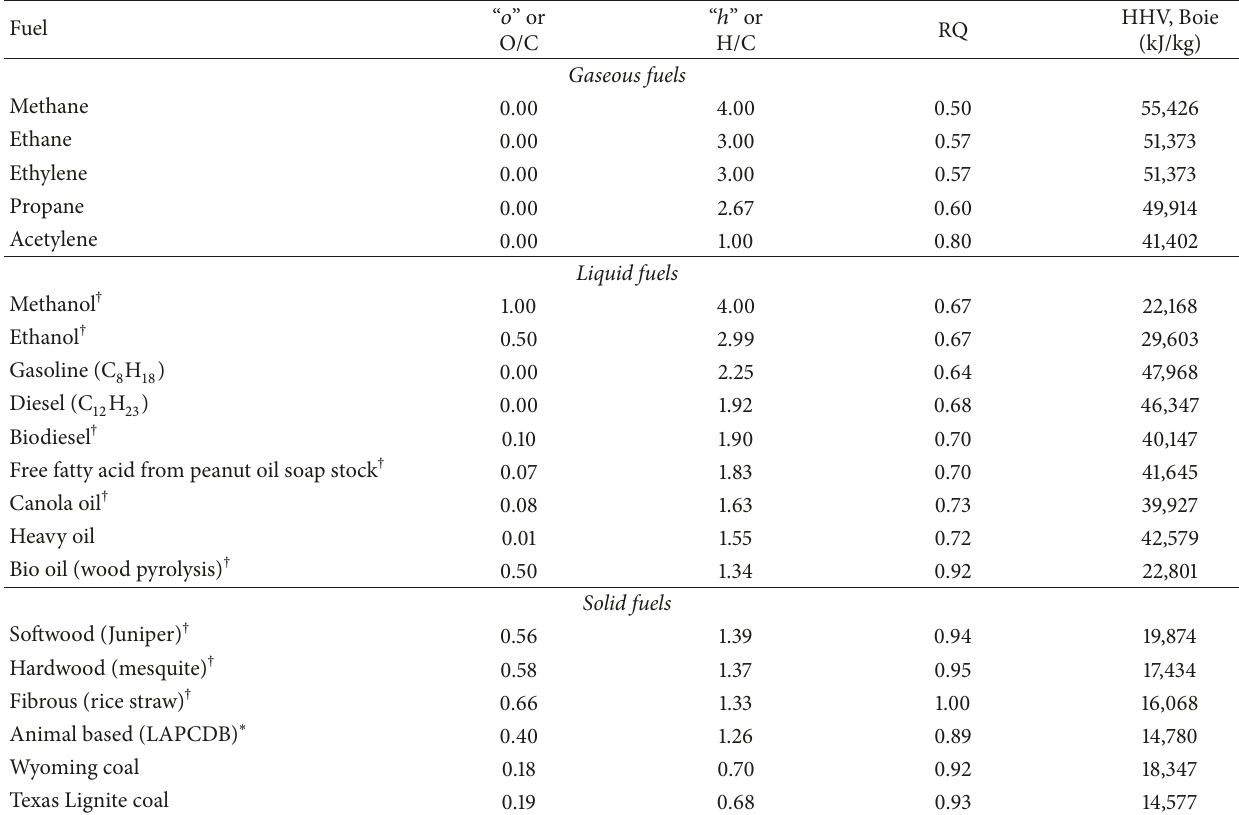
Table 4: RQ factor for different fuels along with their respective O/C and H/C